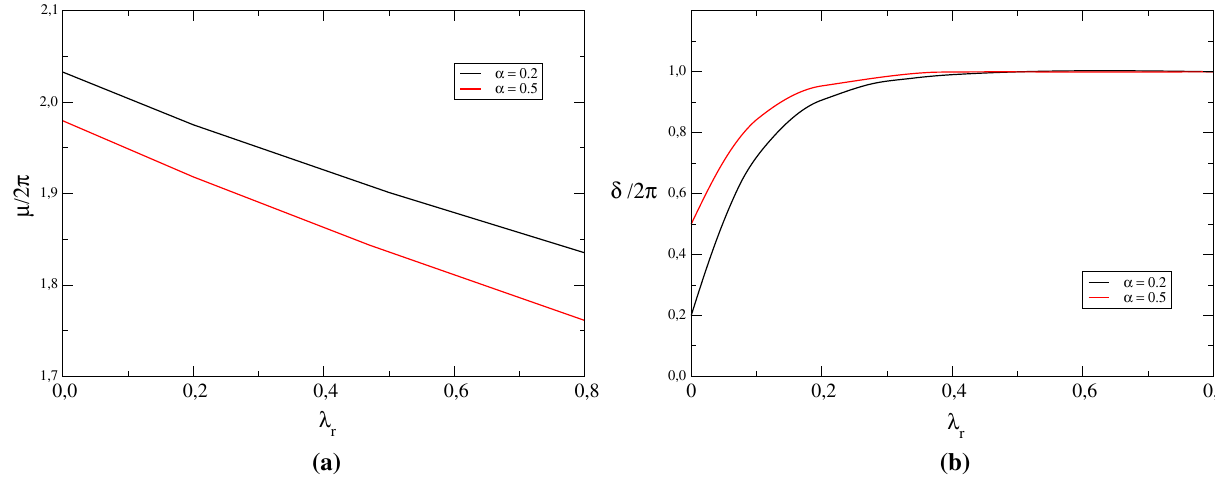
Fig. 4 In the left panel, we present the behavior of the density of the energy per unit of 2 π as a function of λ r . In the right panel, the behavior of the planar deficit angle in units of 2 π as a function of λ